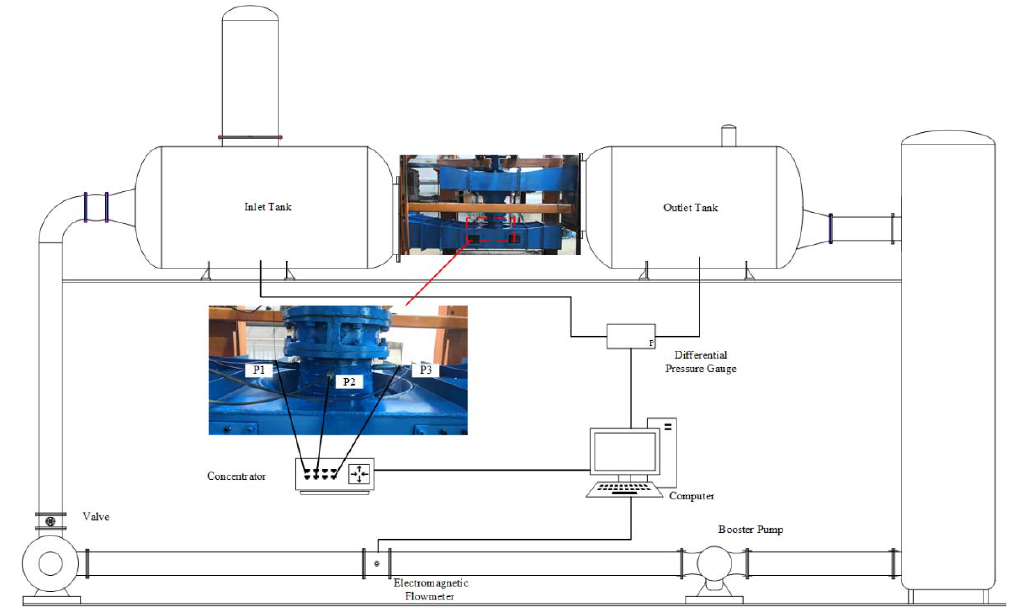
Figure 5. Schematic diagram of closed test rig.